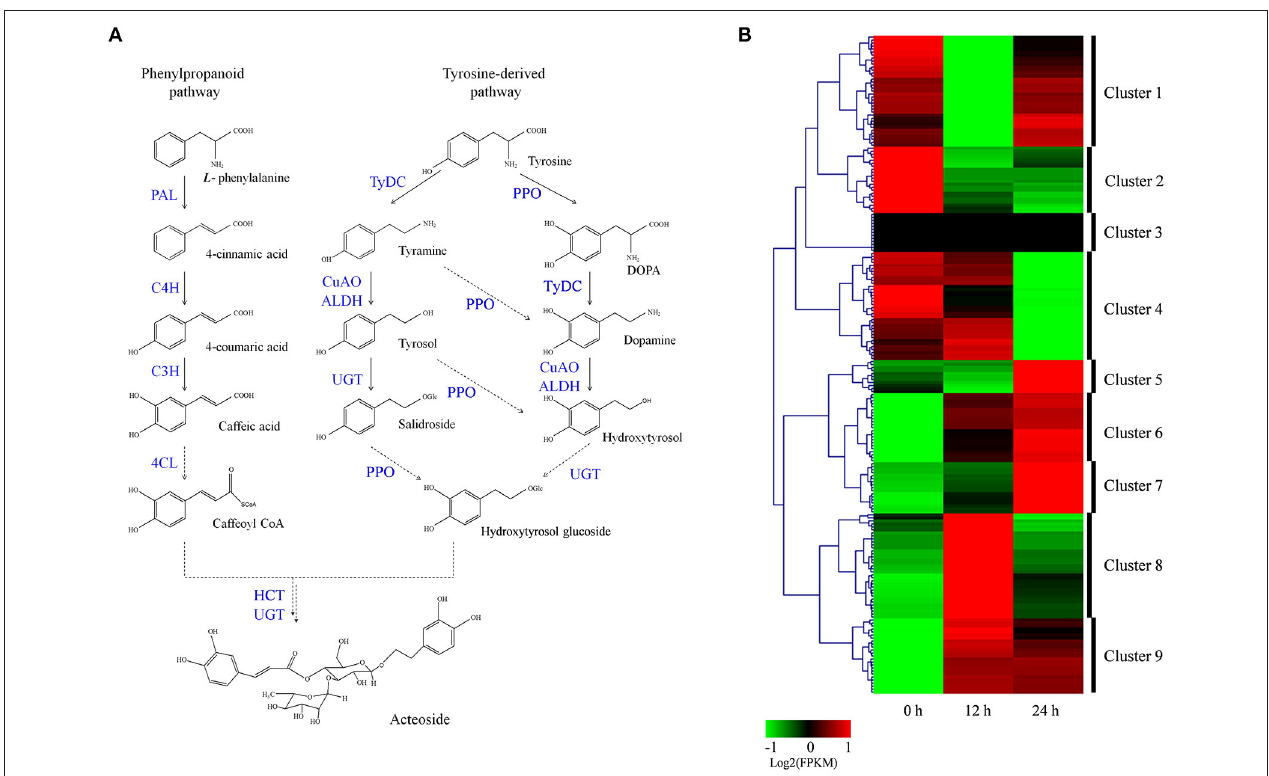
FIGURE 5 | Putative acteoside biosynthesis pathway and expression level of associated unigenes across in R. glutinosa hairy roots with SA treated. (A) Proposed pathway for acteoside biosynthesis. (B) Expression levels of the identified unigenes were annotated as enzyme coding genes from acteoside biosynthesis pathways. The expression value (FPKM) for unigenes were log 2 transformed and scaled across each row, and heatmap was generated by MultiExperiment Viewer (MeV). PAL, phenylalanine ammonia-lyase; C4H, cinnamate-4-hydroxylase; C3H, coumarate-3-hydroxylase; TyrDC, tyrosine decarboxylase; PPO, polyphenol oxidase; CuAO, copper-containing amine oxidase; ALDH, alcohol dehydrogenase; UGT, UDP-glucose glucosyltransferase; 4CL, 4-coumarate-CoA ligase; HCT, Shikimate